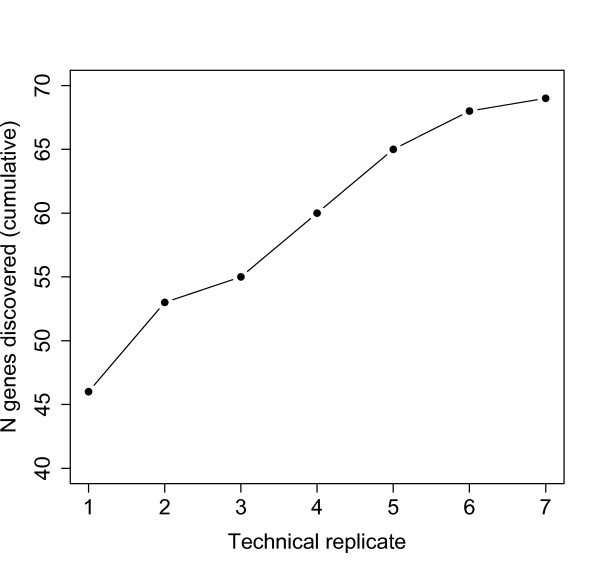
A cumulative distribution showing new genes discovered across technical replicates. The sixth and seventh technical replicate added a combined total of four new genes (out of 69 total), suggesting we have approached an asymptote of new gene discovery.